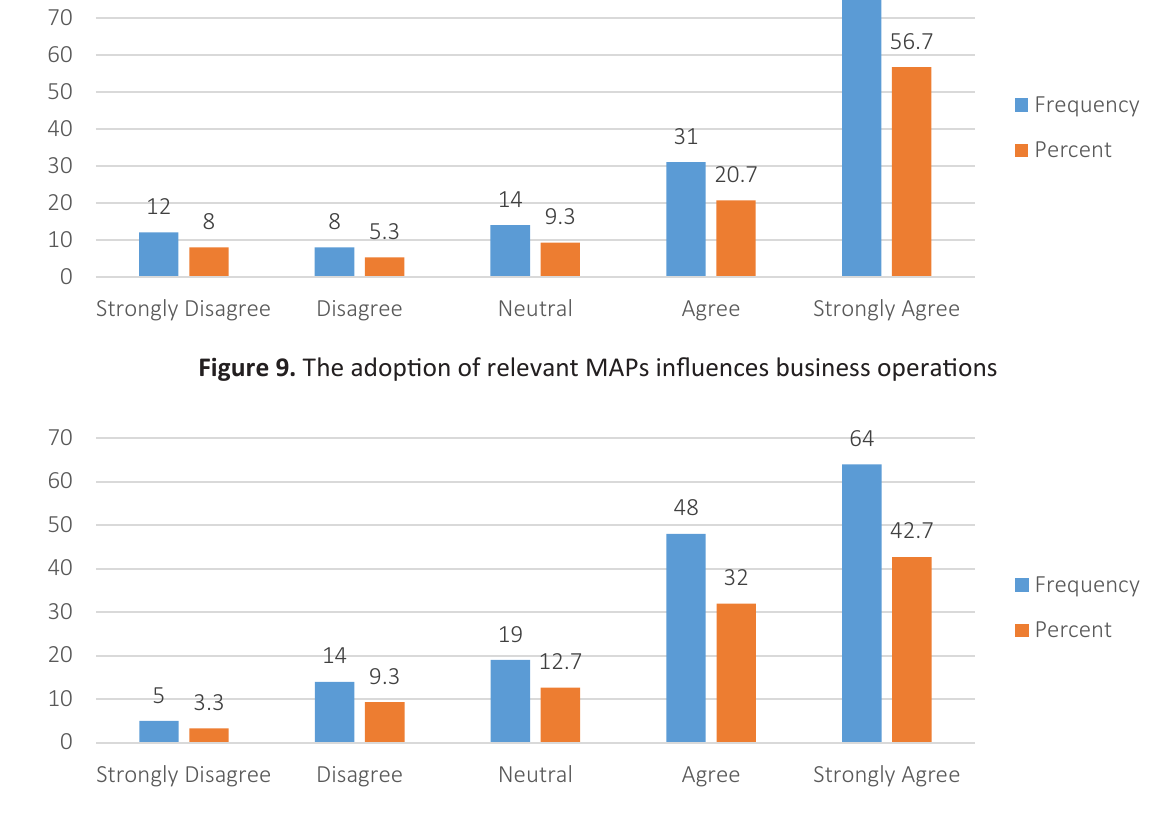
Figure 10. The adoption of MAPs serves as a strategic tool towards business